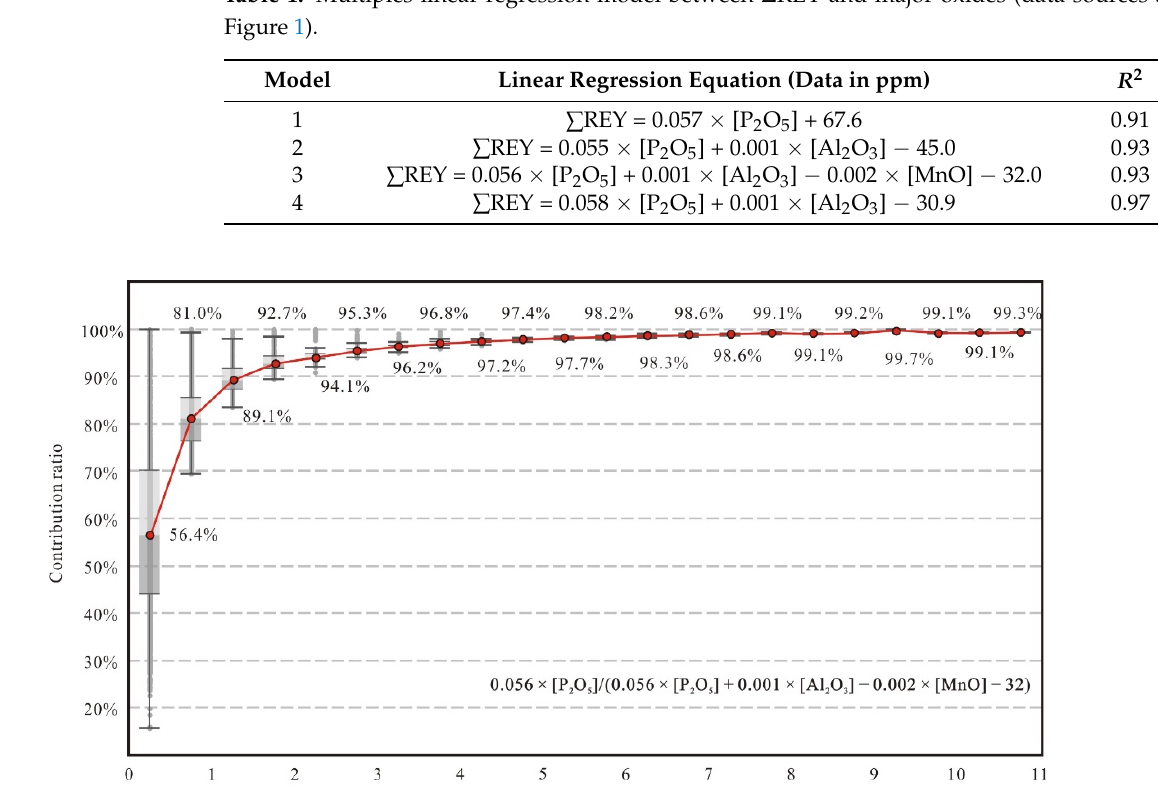
Figure 8. Box ‐ plot diagram of the contribution of phosphate components with different P 2 O 5 contents to REY enrichment. Using 0.056 × [P 2 O 5 ]/(0.056 × [P 2 O 5 ] + 0.001 × [Al 2 O 3 ] − 0.002 × [MnO] − 32.0) to represent the contribution of phosphate components to REY enrichment in deep ‐ sea sediments, the contribution of phosphate components to Σ REY in each sample is calculated. The P 2 O 5 content was divided into 22 groups at intervals of 0.5, and the median of the box ‐ plot was used to indicate the content trend of each group of data.